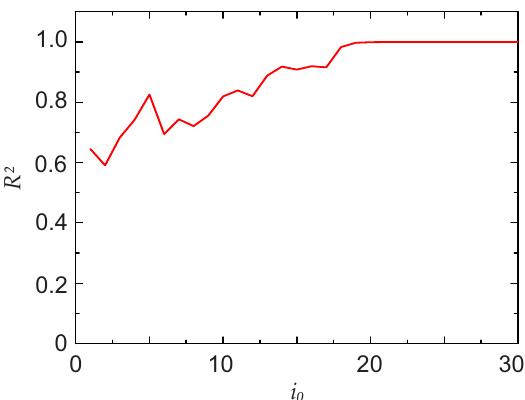
Figure 3. Evolution of R 2 with increasing value of the cut-off i 0 . The data correspond to the third scenario described in Section